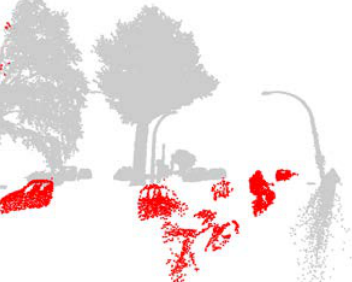
Figure 4 Dynamic objects (red) detected by using knowledge of a two sensor system.